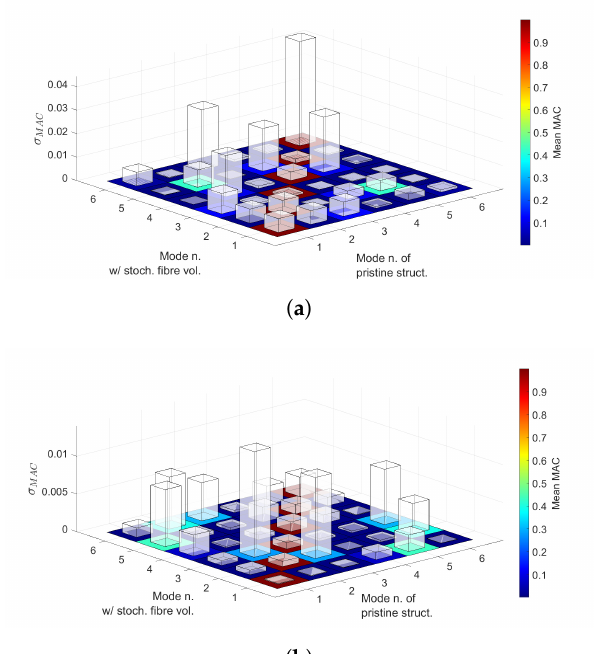
Figure 16. ( a ) Case 1 3D MAC matrix, ( b ) Case 2 3D MAC matrix. Floor indicates the mean value and bars the standard deviation of each component of the matrix. Fibre volume fraction is treated as a Gaussian random variable with mean value V f = 0.60 and standard deviation σ V fibre waviness.